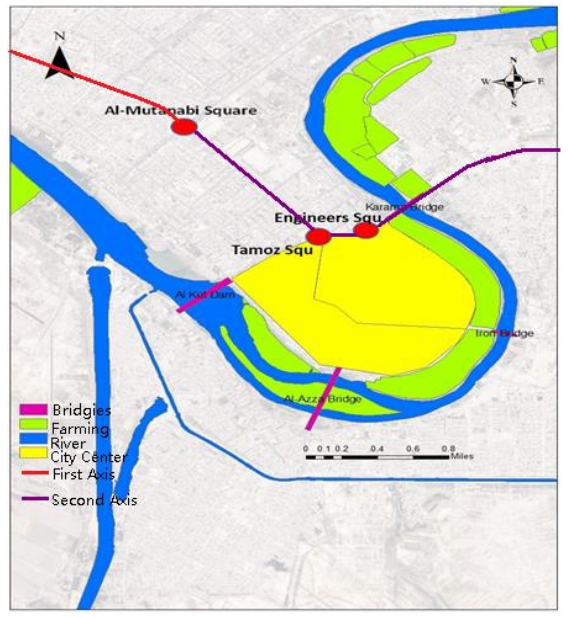
Fig. 4. Al-Kut city centre with its bridges